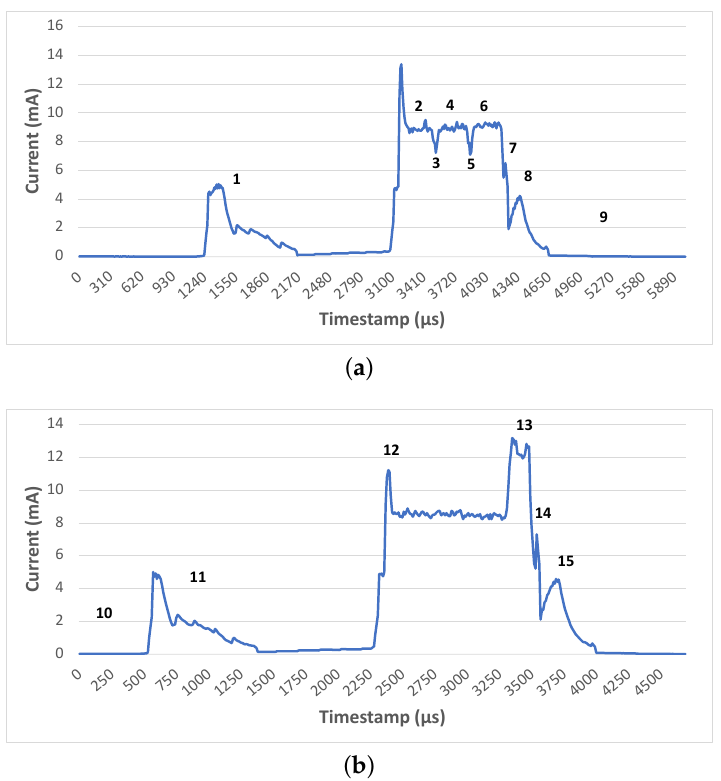
Figure 5. Current consumption of nRF52840 with the state number as defined in Table 1. ( a ) Current consumption during FP; ( b ) Current consumption during